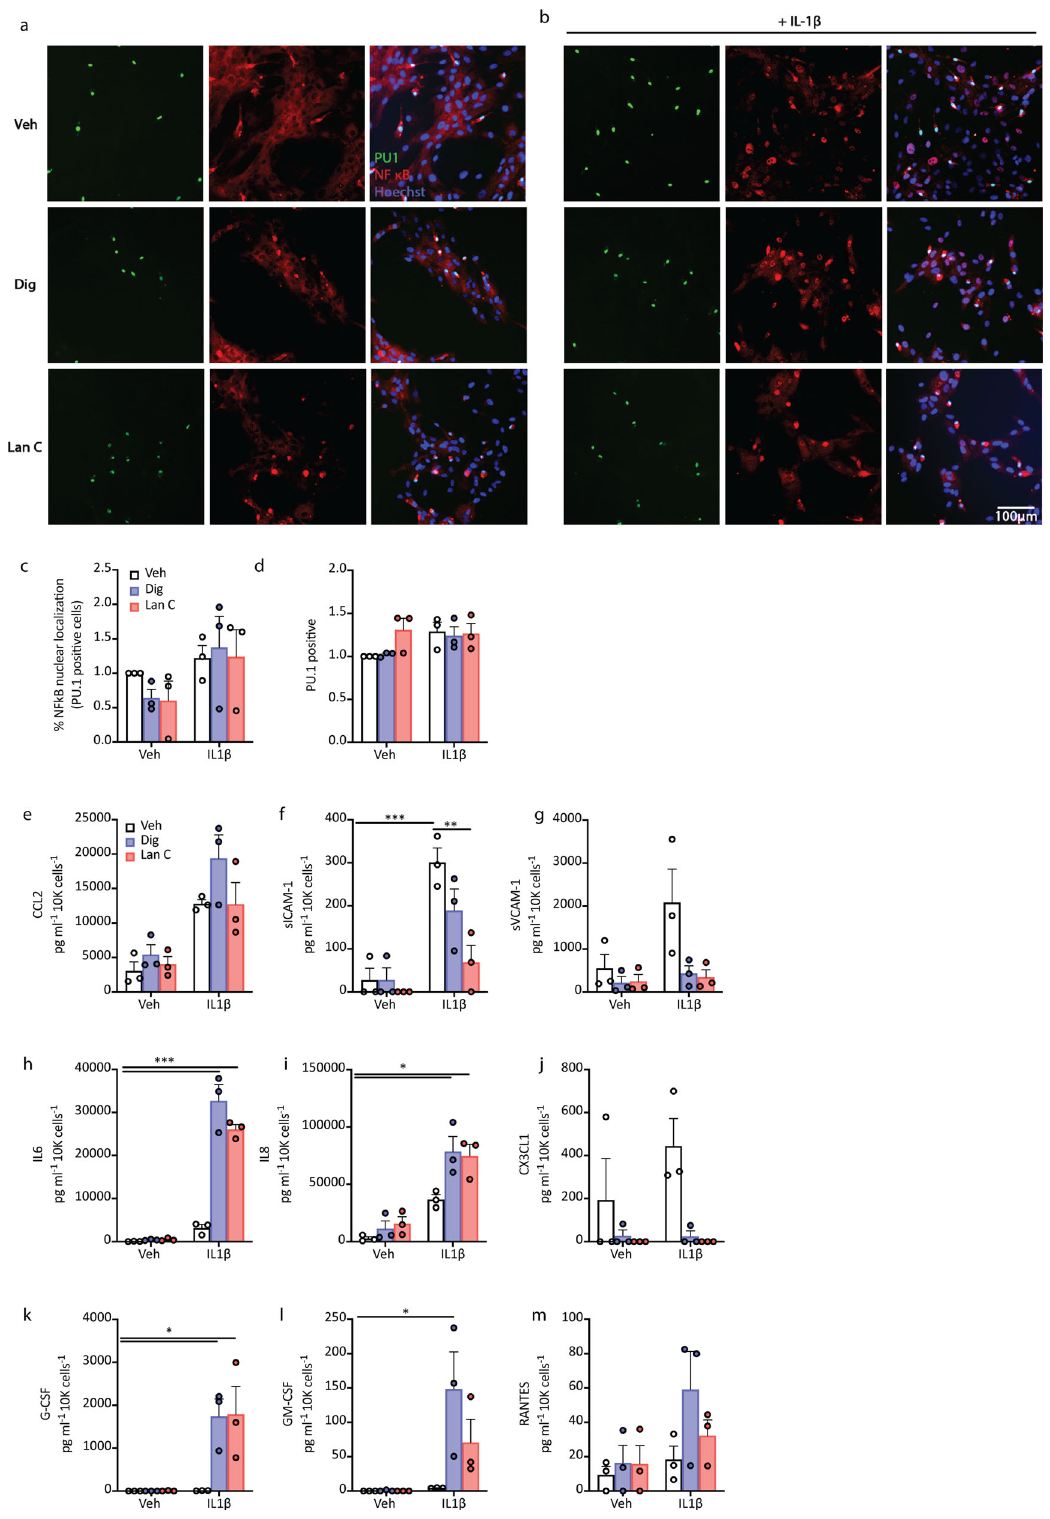
Fig. 3 Cardiac glycosides modulate cytokine secretions from mixed glial cultures of microglia and pericytes. a , b Mixed glial cultures were treated with cardiac glycosides for 24 h prior to stimulation with IL1 β for 1 h (( a ) representative images). In fl ammatory response was assessed by NF κ B nuclear translocation in PU.1 positive microglia ( c , d ). e – m Conditioned media from mixed glial cultures after 24 h of vehicle (white bars), digoxin (100 nM, blue bats) or lanatoside C (1 μ M, red bars) pretreatment prior to stimulation with IL1 β (0.05 ng mL − 1 ) for 24 h ( n = 3, case used E215, E216, SS54). Two-way ANOVA with Tukey ’ s multiple comparison test, mean ± SEM.*** p < 0.001, ** p < 0.01, * p <